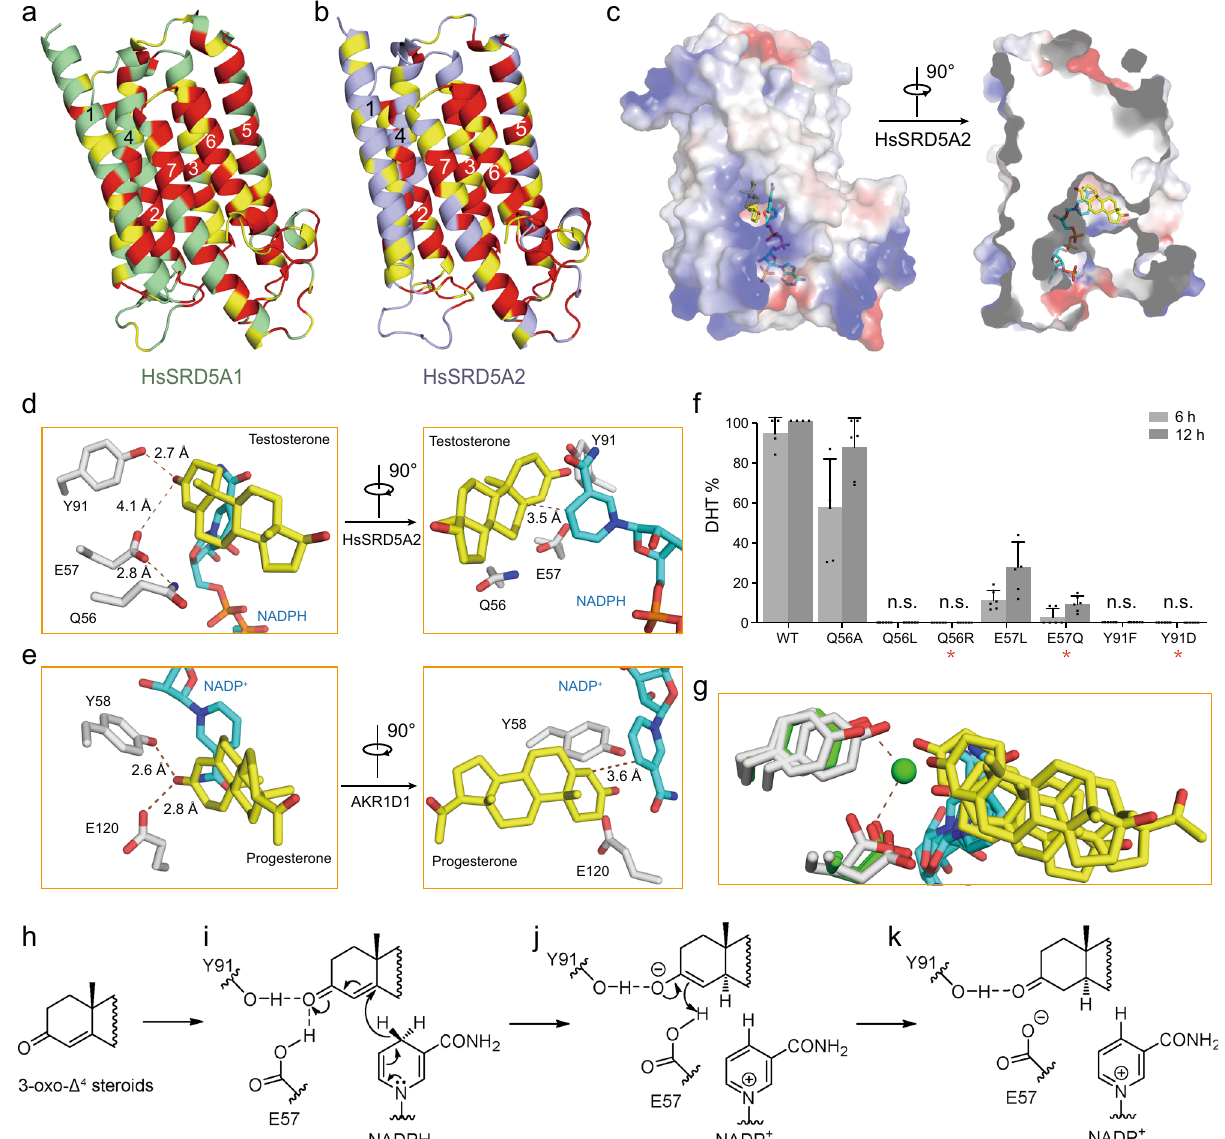
Fig. 3 HsSRD5A1 and -2 modeling, substrate docking, and functional characterization. a HsSRD5A1 homology model was generated on the basis of PbSRD5A structure and represented in palegreen. Invariant and conserved residues are colored in red and yellow, respectively. b HsSRD5A2 homology model was generated on the basis of PbSRD5A structure and represented in lightblue. c The docking pose of testosterone in HsSRD5A2 structural model. The semi-transparent electrostatic surface of HsSRD5A2 is shown. Testosterone is shown as yellow stick. NADPH is colored cyan. d The coordination of conserved Q-E-Y motif with testosterone in HsSRD5A2 docking model. Two perpendicular views are shown. e The coordination of conserved Q-E-Y motif in AKR1D1-progesterone complex structure. f Biochemical characterization of the Q-E-Y motif of HsSRD5A2. All variants were transient expressed in HEK293T cells for 24 h. The cells were treated with [3H]-labeled T for 6 or 12 h. The collected and homogenized cell membranes were treated with [ 3 H]- labeled T. HsSRD5A2 activities were measured by the percentage of DHT detected by HPLC. Data are mean ± s.d. derived from technically independent experiments in duplicate. Each experiment was reproduced three times on separate occasions with similar results. Red stars (*) indicate the variants in patients. g The water molecule, coordinated by the Q-E-Y motif in PbSRD5A structure, was shown in green sphere. The water molecule occupied the space for the C-3 carbonyl oxygen in the docking results shown in Fig. 3d and Supplementary Fig. 7d, f. h Key structural features of 3-oxo- Δ 4 steroids. i The tyrosine (Y91 in HsSRD5A2) and glutamate (E57 in HsSRD5A2) may form hydrogen bonds to the carbonyl oxygen of substrates. Y91, as a super acidic hydrogen bond donor, helps to activate α , β -unsaturated ketone moiety of substrates. j The proposed mechanism of reduction involves a two-step reduction by the enzyme and NADPH. In the fi rst step, NADPH coordinates on α face of the substrate and adds a hydride to C5, leading to a selective reduction at C5 to form an enolate ion intermediate. k Second, the resonance-stabilized enolate ion is protonated by E57 at C4 and thus releasing a saturated ketone product and an NADP + mutants, Q56A/L, E57L, and Y91F lost reductase activity includes Y91 and E57 (Fig. 3d) and for AKR1D1, Y58 and E120 unambiguously (Fig. 3f) with equally expression level (Supple- (Fig. 3e) 39 . Additionally, Q56 of HsSRD5A2 bonded with E57 to mentary Fig. 8), indicating the importance of these residues in stabilize the local conformation in HsSRD5A2 (Fig. 3d). In the substrate recognition and reduction. The Q56R, E57Q, and Y91D reductase activity assay using cells containing HsSRD5A2